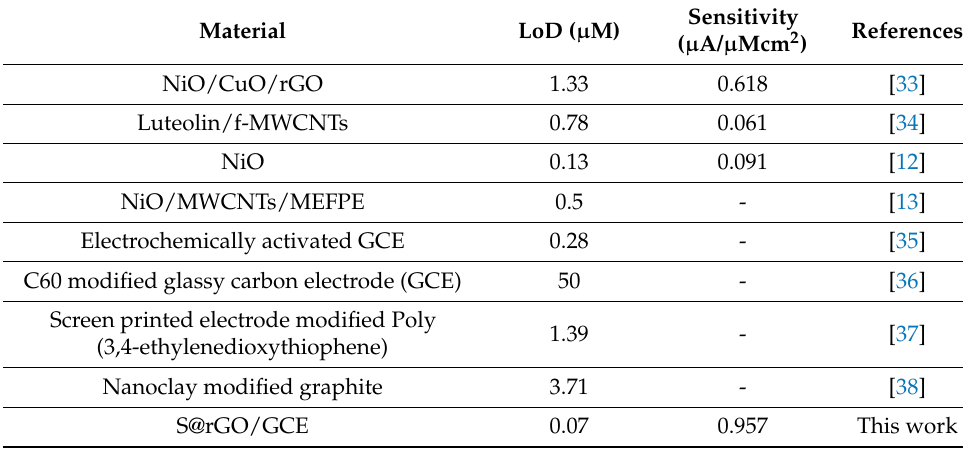
Table 1. Comparison of LoD, linear range, and sensitivity of S@rGO/GCE with recent reports [12,13,